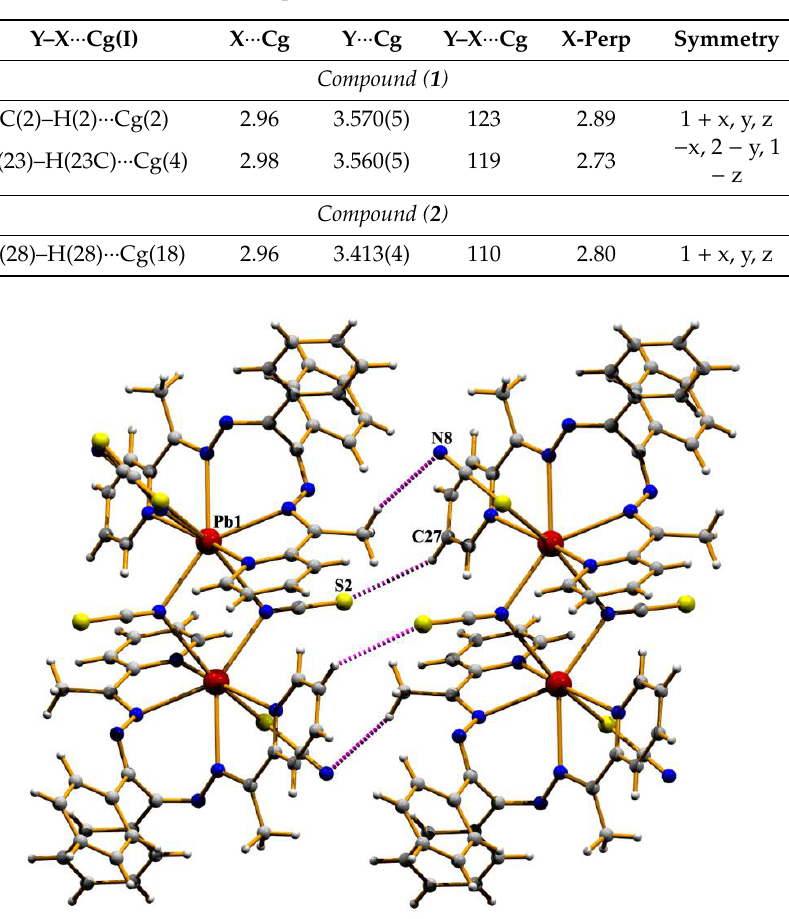
Figure 2. Partial view of the X-ray structure of ( 1 ) with indication of C–H∙∙∙N and C–H∙∙∙N H-bonds.